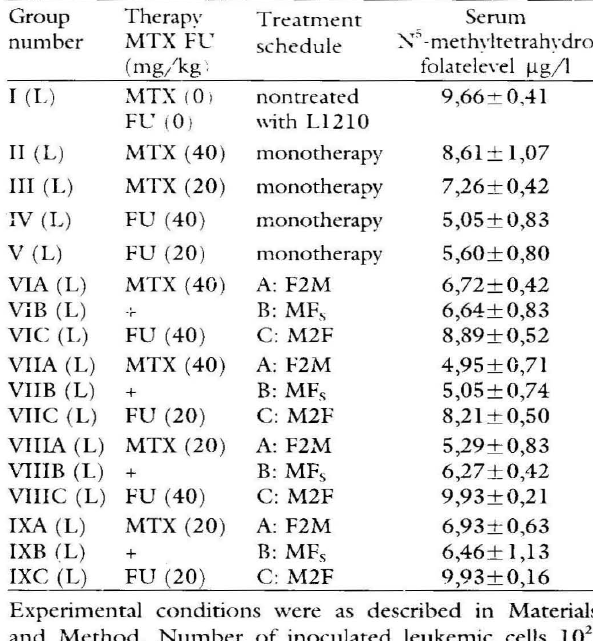
Table 9. N'-methyltetrahydrofolate levels in the serum of BDF, mice with L1210 leukemia after administration of MTX, FU and combined therapy according to dif- ferent schedules